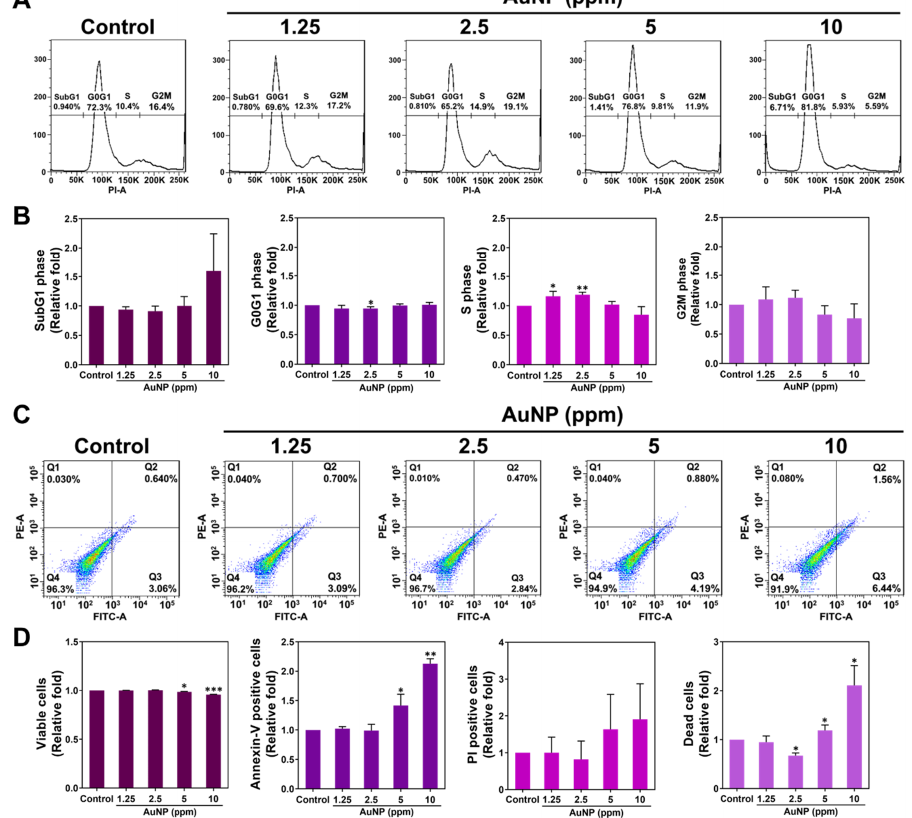
Figure 6. Cell cycle progress and Apoptosis of MSCs with AuNP treatments. ( A ) The cell cycle histograms of MSCs were acquired through the FACS method. ( B ) The relative fold of the Sub-G1 phase, G0G1 phase, S phase and G2M phase were quantified. The results indicate no significant difference at the Sub-G1 phase in each experimental group except for the higher ratio in the 10 ppm AuNP treatment. Furthermore, the ratio at the S phase was significantly higher in both 1.25 and 2.5 ppm AuNP groups, demonstrating the enhancement of cell proliferation. ( C ) Apoptotic MSCs were also detected via the FACS method. ( D ) The viable cells, apoptotic cells and dead cells were semi- quantified. The data of Annexin-V positive cells (apoptosis) evaluated there was no significant dif- ference when treated with 1.25 and 2.5 ppm AuNPs. On the contrary, 5 and 10 ppm AuNPs induced more apoptotic and dead cells. The histograms were chosen from one of three independent experi- ments. Semi-quantifications are evaluated as mean ± SD ( n = 3). * p < 0.05, ** p < 0.01, *** p < 0.001: compared to the Control group (TCPS). Next, the apoptosis of the MSCs after various AuNP treatments was also investigated via the FACS method. Figure 6C,D demonstrate the histograms and quantitative data after 48 h of treatments, respectively. We analyzed the quantitative results with the exploration of a higher Annexin-V positive cells population (presented as apoptotic cell) induced by AuNPs at the concentration of 5 and 10 ppm, while the similar trend also shared in the detection of PI positive cells (presented as necrotic cells). The results of viable MSCs demonstrated the decreased level with significant difference in AuNP 5 and 10 ppm. On the contrary, the treatment of AuNP 1.25 and 2.5 ppm did not induce higher Annexin-V positive and PI positive MSCs (Figure 6D). Discussed with the viable and dead MSCs stimulated by each treatment, the results elucidated that the 2.5 and 5 ppm AuNP